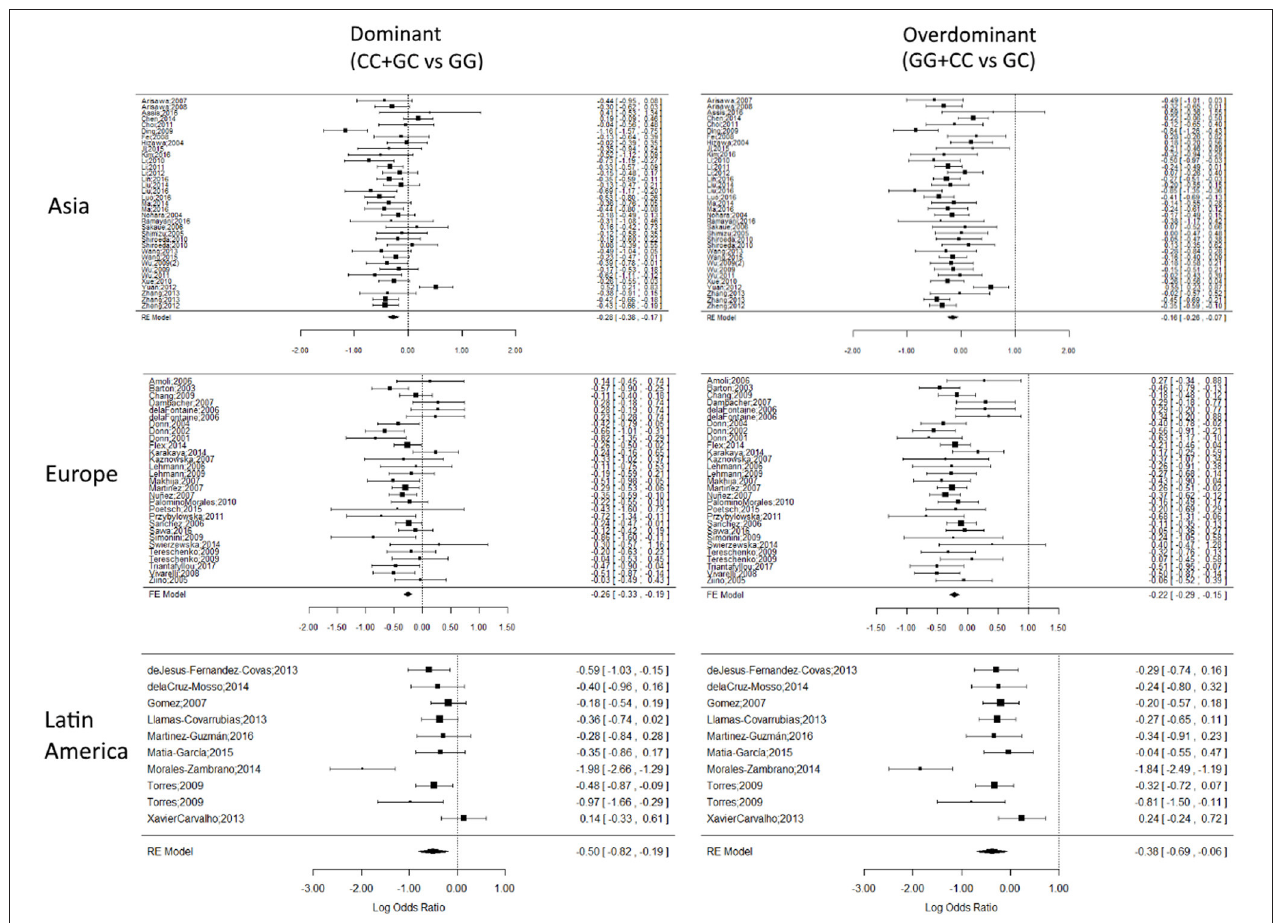
FIGURE 3 | Representative forest plots. Forest plots of Asian, European and Latin American subdivisions on the dominant and overdominant models. The squares correspond to the study-specific OR, and the size reflects its weight. Horizontal lines correspond to the 95% CIs. The diamond represents the pooled ORs and 95% CIs of the overall population. The vertical solid line shows the Log OR of 0. There was no evidence of bias or the dominant effect of a single cohort over the global OR